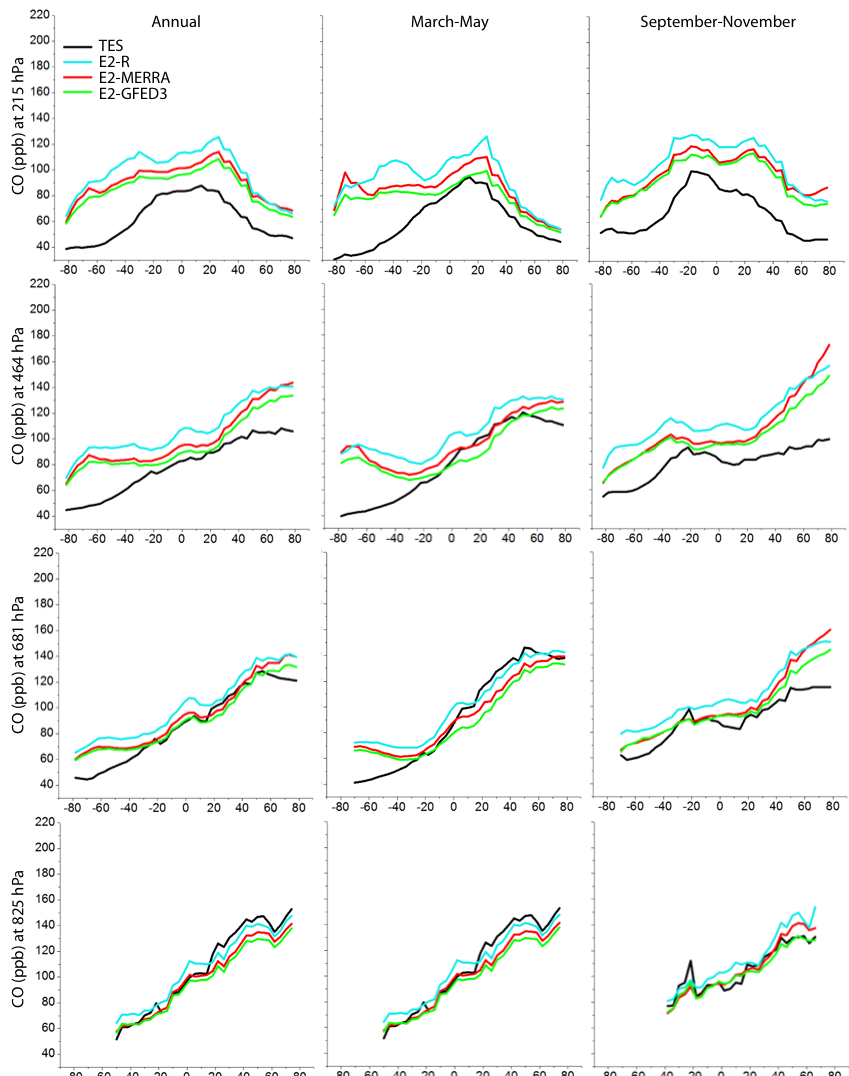
Fig. 9. Zonal mean CO at the indicated pressure levels in 2005–2009 TES observations and in three model simulations for the annual average and boreal spring and